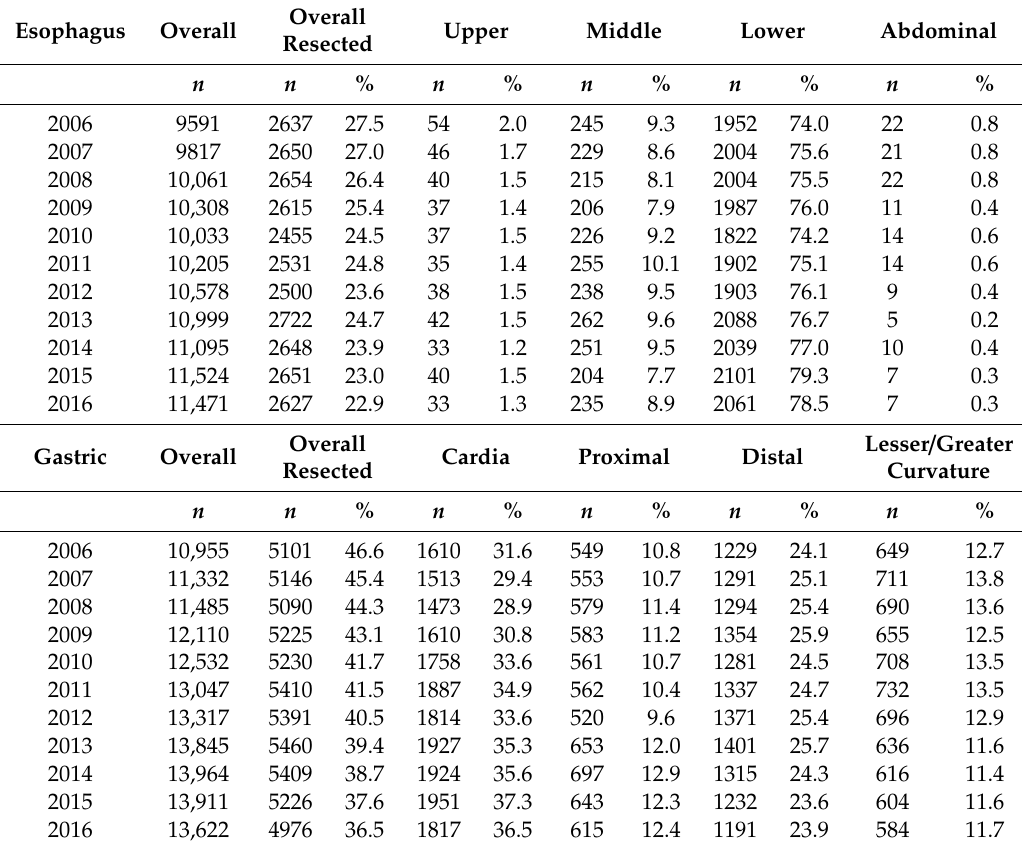
Table 1. Yearly number of all tumors of the esophagus and stomach and number resected by its anatomic